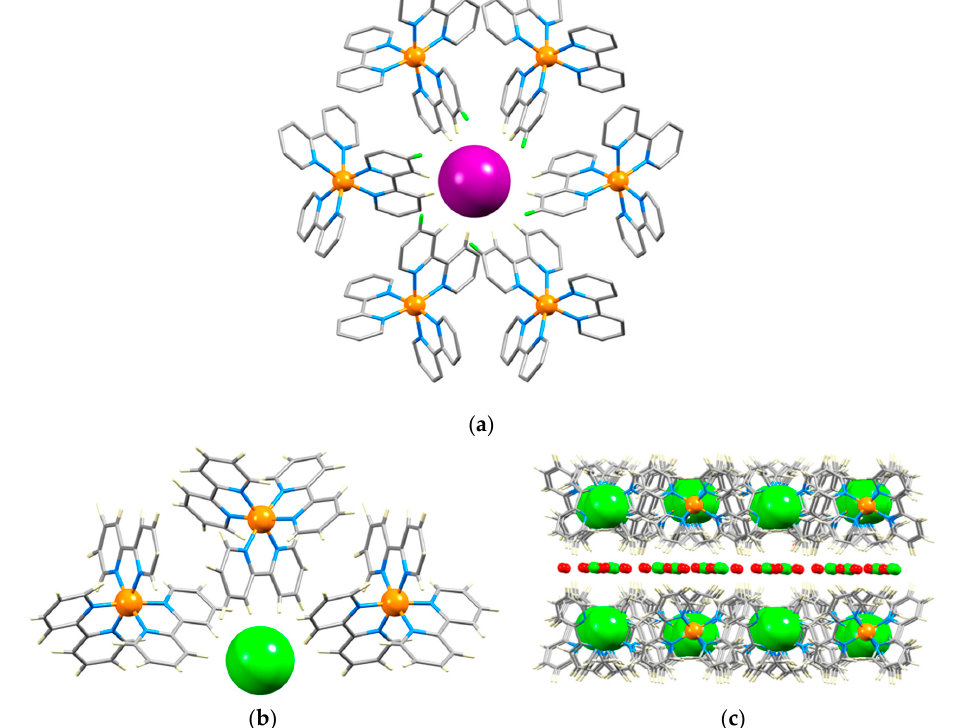
Figure 4. The Structure Type 1 motif can persist with fewer interactions with the [M(bpy) 3 ] n +